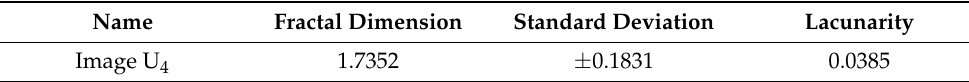
Figure 14. Voxel representation for the image U 2 . Table 3. Calculation of fractal parameters for picture U 4.